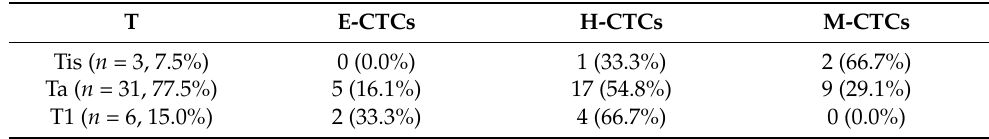
Table 5. NMIBC patient distribution ( n = 40) according to the different EMT phenotype and patho- logical T stage in blood CTCs.